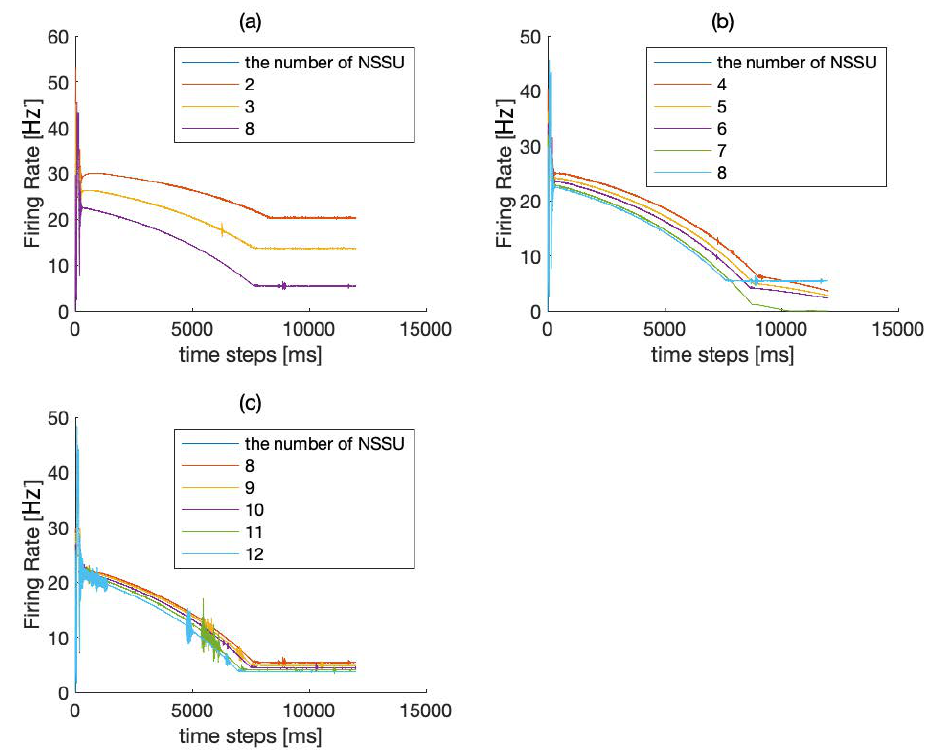
Figure 5. ( a ) Comparison of 2–12 NSSUs. The meaning of “time steps”: steps represent the number of iteration steps of the ordinary differential equation in the mean field model. The firing rate